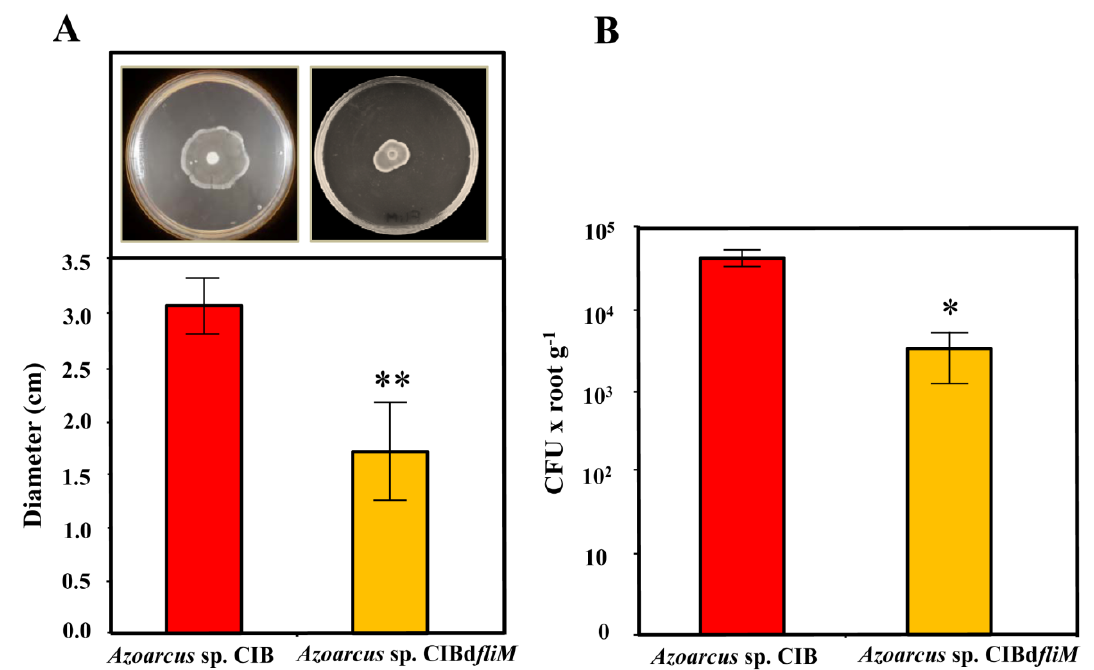
Figure 1. Swimming and rice colonization phenotypes of the Azoarcus sp. CIB and Azoarcus sp. CIBd fliM strains. ( A ) Swimming motility of the Azoarcus sp. CIB (carrying the control plasmid pSEVA237) and Azoarcus sp. CIBd fliM strains, and quantification of the diameter of the halos ( n = 3); the error bars indicate the standard deviation. Two asterisks mean a very significant difference ( p = 0.0076), according to paired t -test. ( B ) Quantification of the number of endophytes recovered from rice roots after inoculation with Azoarcus sp. CIB (pSEVA237) and Azoarcus sp. CIBd fliM strains. Graph shows the CFU values per gram of root (fresh weight) from three independent experiments ± standard deviation. An asterisk means a significant difference ( p = 0.0319), according to paired t -test.